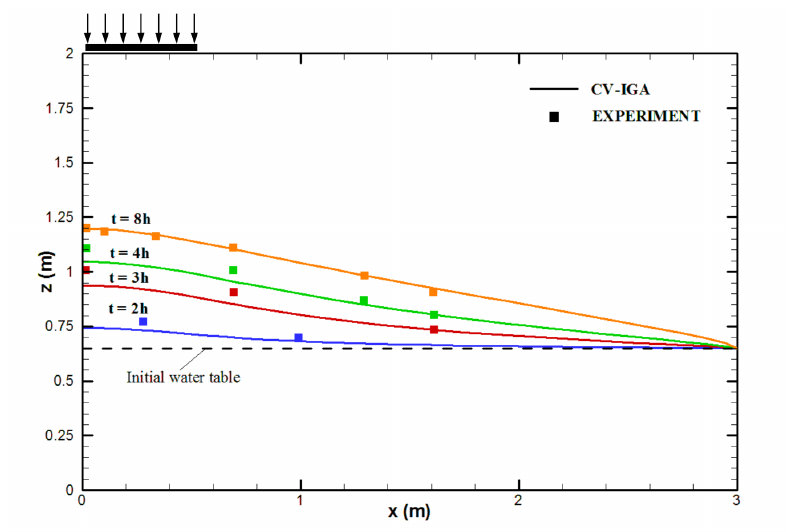
Figure 3. Water-table positions for infiltration study of [55].